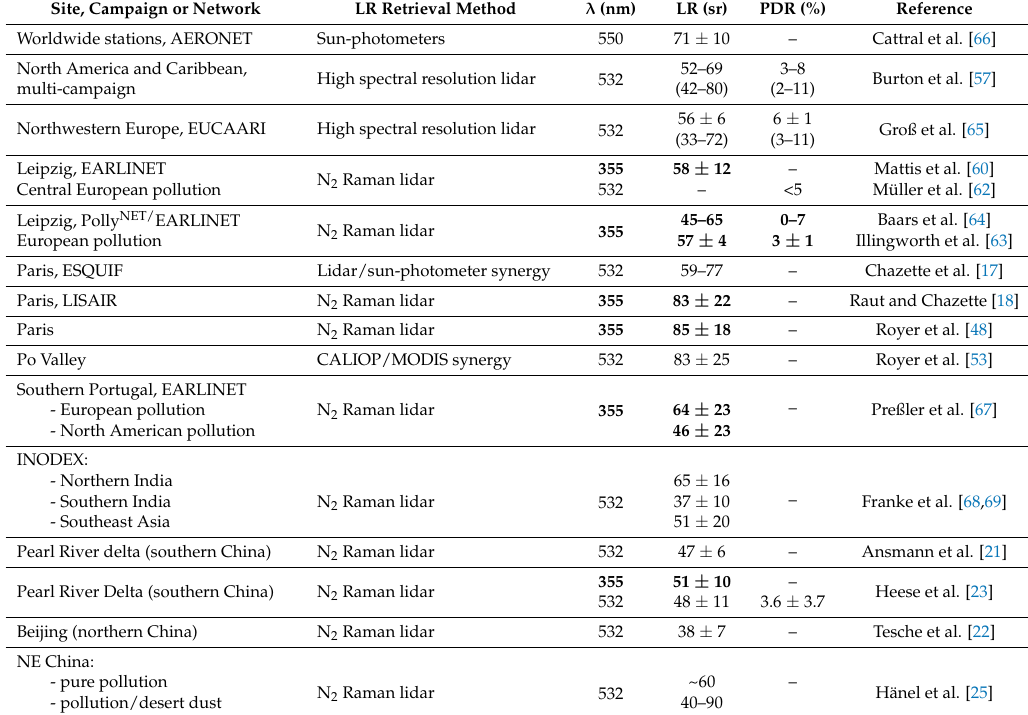
Table 3. Values of the Lidar Ratio (LR) and the linear Particle Depolarization Ratio (PDR) reported in the literature for pollution aerosols. For Burton et al. [57], values are the 25–75th (5–95th) percentile; for other authors, they are the average and 1- σ standard deviation, plus (extreme values) for Groß et al. [65]. Bold numbers highlight observations made at the same wavelength as in this